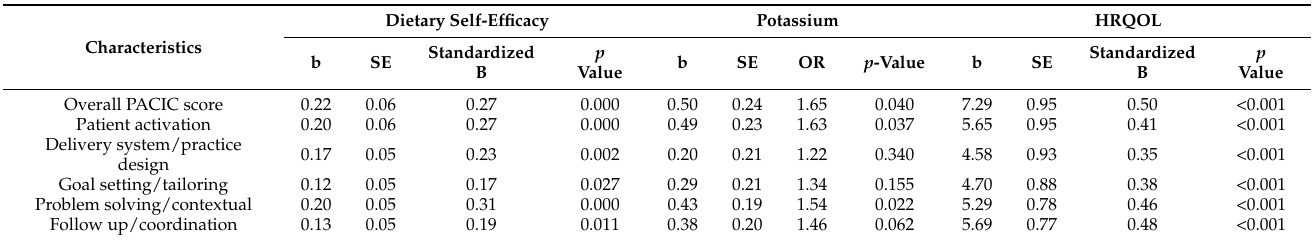
Table 3. Association of dietary self-efficacy, serum potassium, HRQOL and PACIC by the multiple (logistic) regression